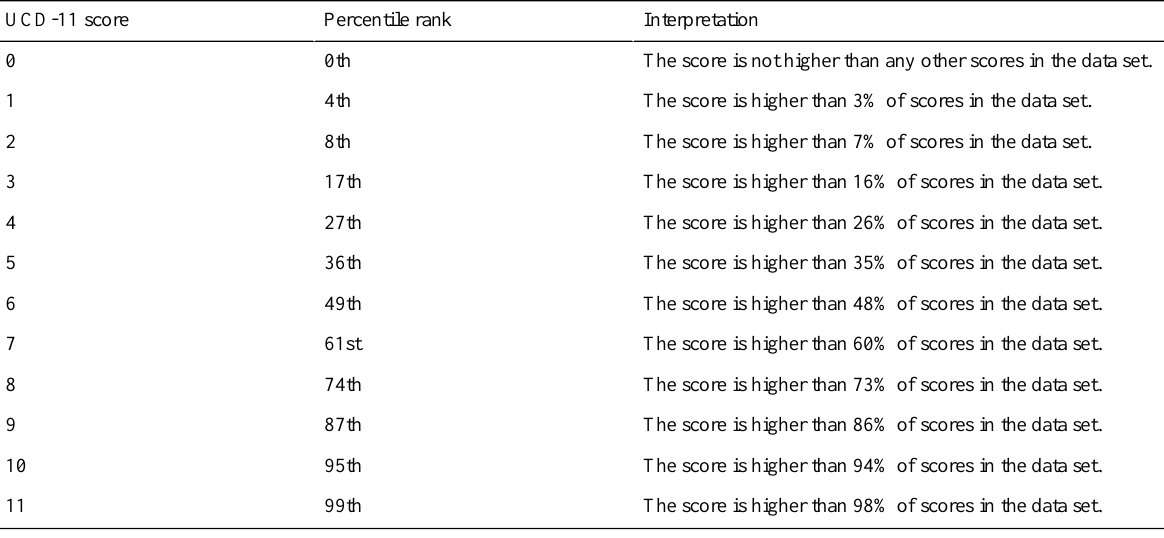
Table 2. Percentile ranks of the User-Centered Design 11-item scale (UCD-11) scores. InterpretationPercentile rankUCD-11 score The score is not higher than any other scores in the data set.0th0 The score is higher than 3% of scores in the data set.4th1 The score is higher than 7% of scores in the data set.8th2 The score is higher than 16% of scores in the data set.17th3 The score is higher than 26% of scores in the data set.27th4 The score is higher than 35% of scores in the data set.36th5 The score is higher than 48% of scores in the data set.49th6 The score is higher than 60% of scores in the data set.61st7 The score is higher than 73% of scores in the data set.74th8 The score is higher than 86% of scores in the data set.87th9 The score is higher than 94% of scores in the data set.95th10 The score is higher than 98% of scores in the data